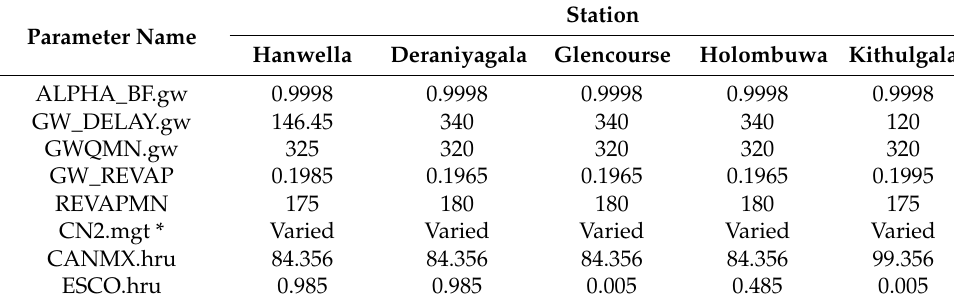
Table 9. Fitted values for calibrated model parameters.